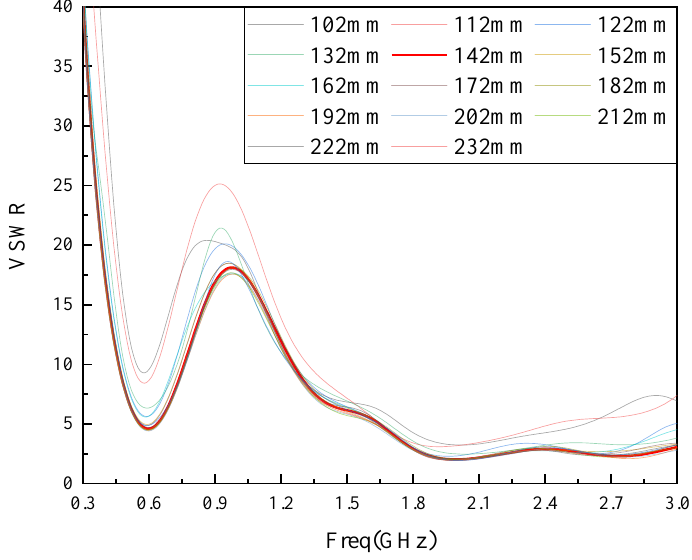
L Figure 1. L 2 parameter simulation optimization Figure 1. 2 parameter simulation optimization diagram.